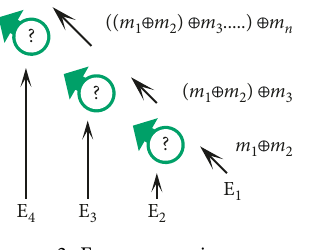
Figure 3: Fuzzy reasoning